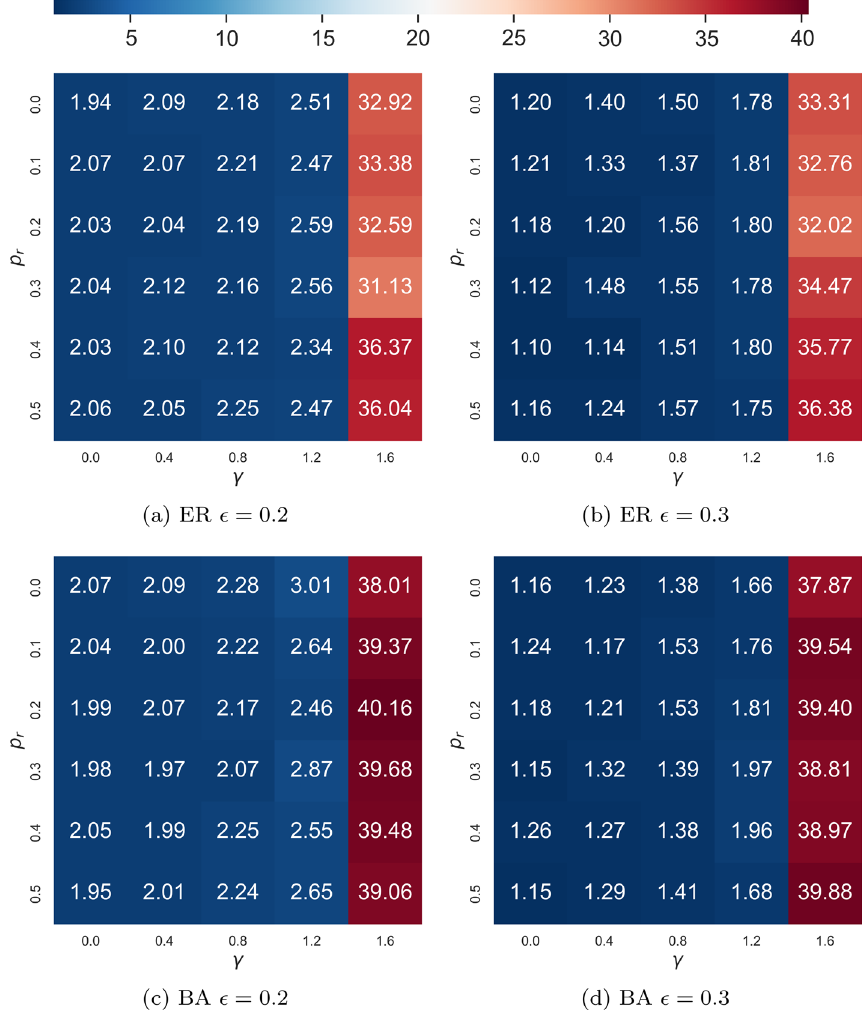
Fig. 3 Average number of clusters in the steady-state of the Adaptive Algorithmic Bias model. The average number of clusters in the final state of the Adaptive Algorithmic Bias model as a function of γ and p r for a ǫ = 0.2 and b ǫ = 0.3 startingr from the Erdős–Rényi graph and c , d starting from the scale-free Barabási– Albert graph. These values are averaged over 30